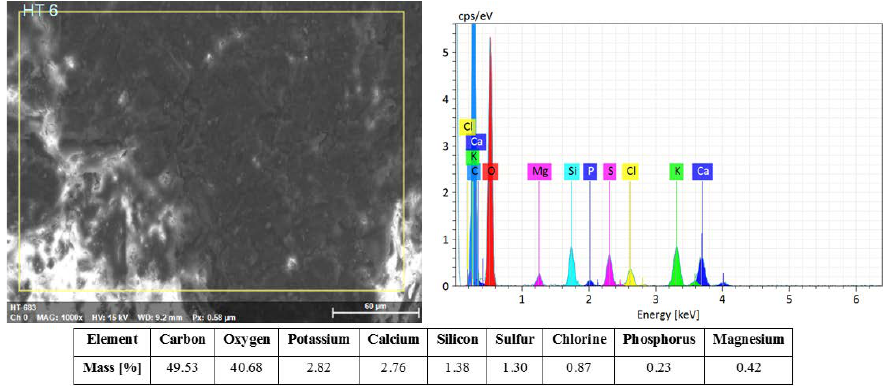
Figure 5. SEM-EDS analysis of horsetail.